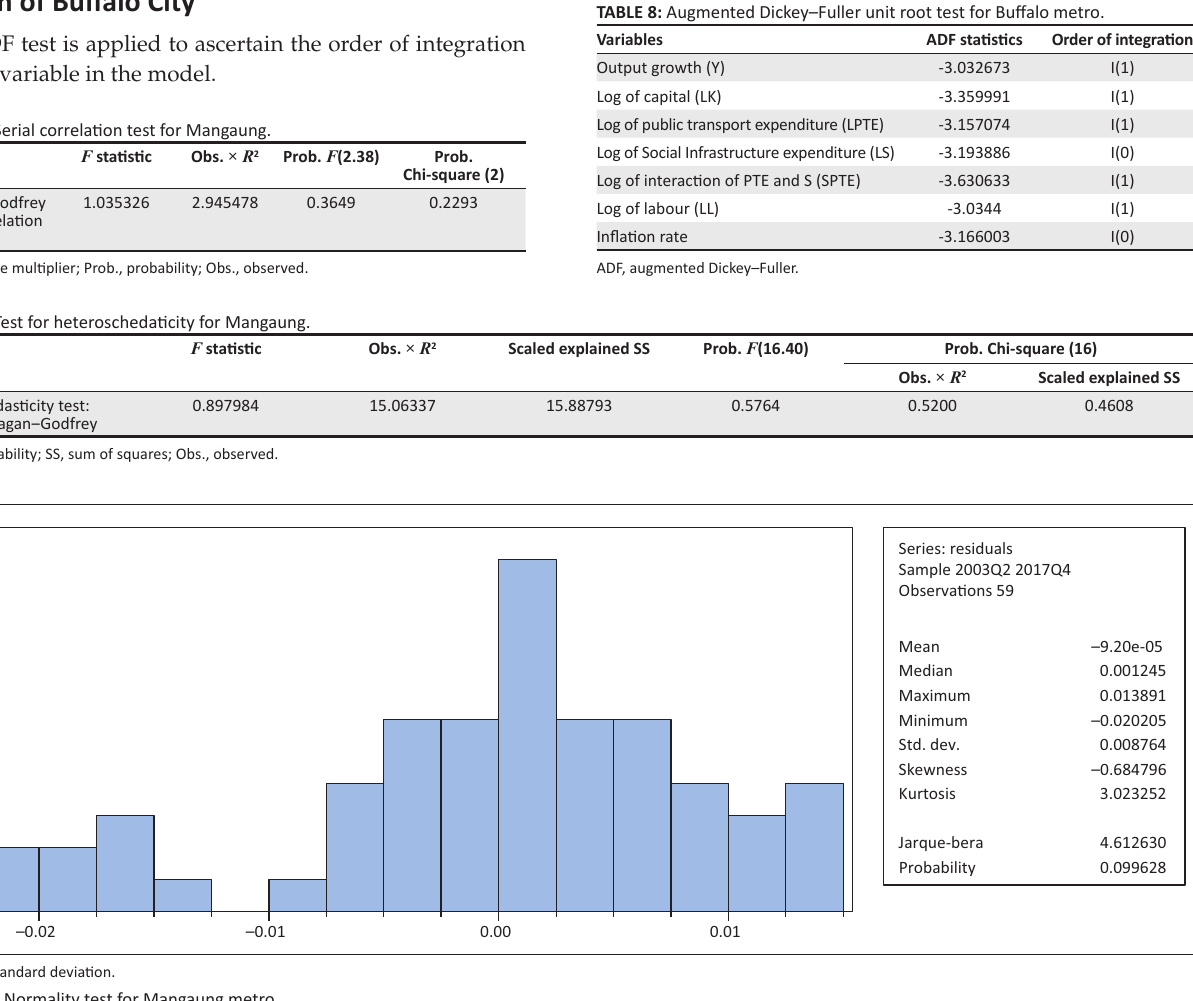
FIGURE 2: Normality test for Mangaung